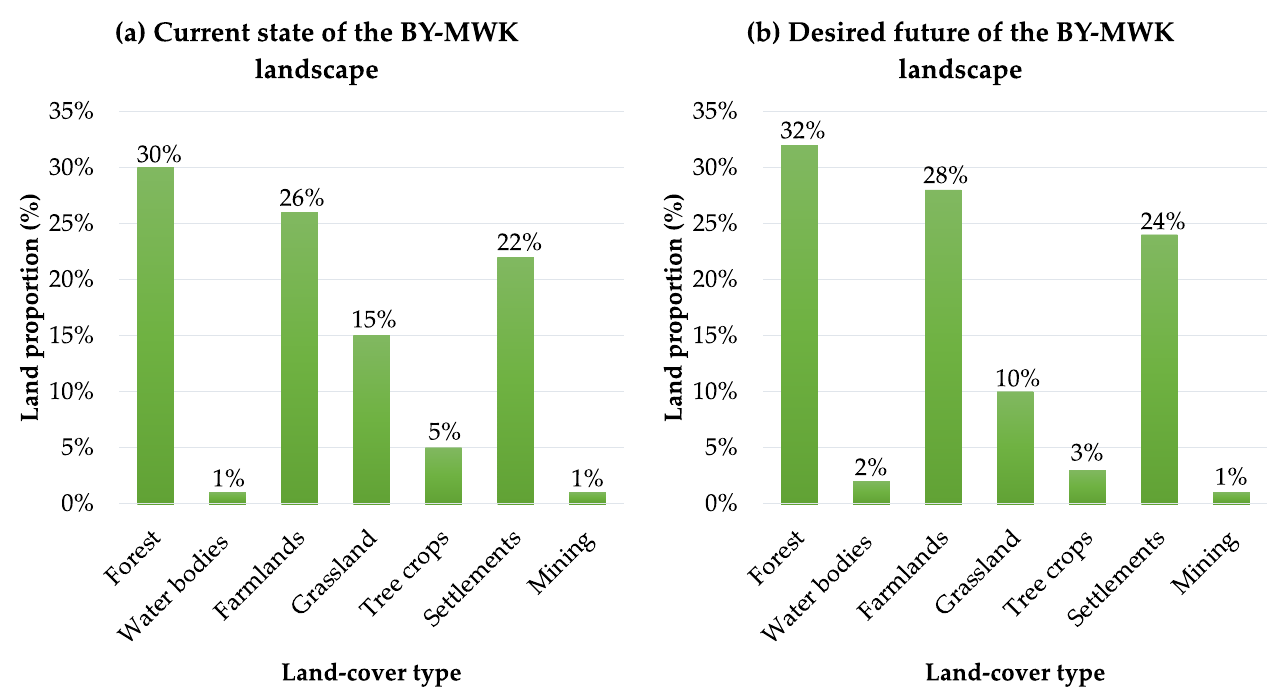
Figure 9. Consensus perception of the current state ( a ) and desired future composition ( b ) of the Builsa Yenning (BY)-Moagduri Wuntanluri Kuwomsaasi (MWK) landscape.